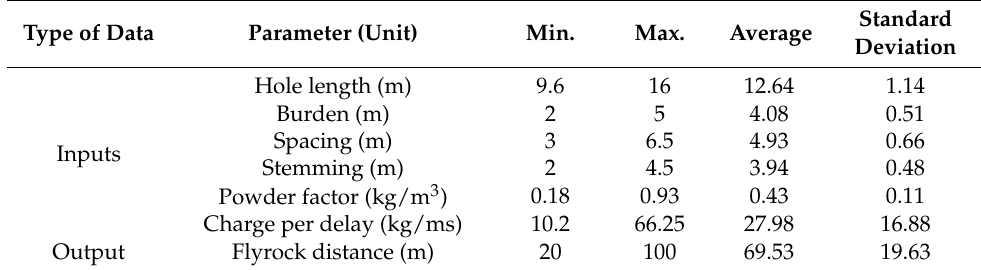
Table 3. The input and output parameters used in ANN [72].